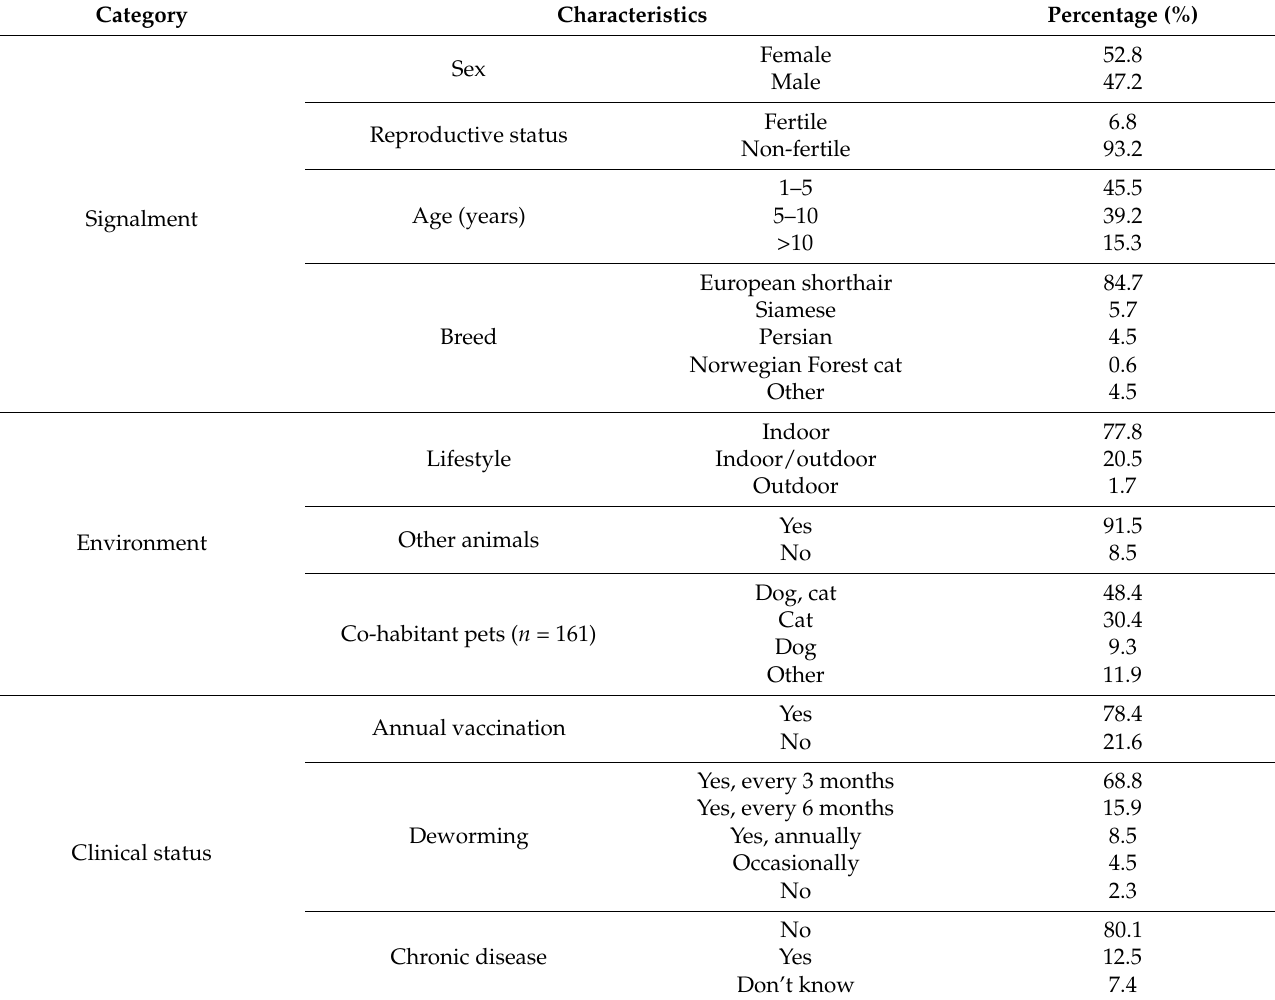
Table 2. Characterization of sampled cats. n = 176; otherwise, n value is presented.